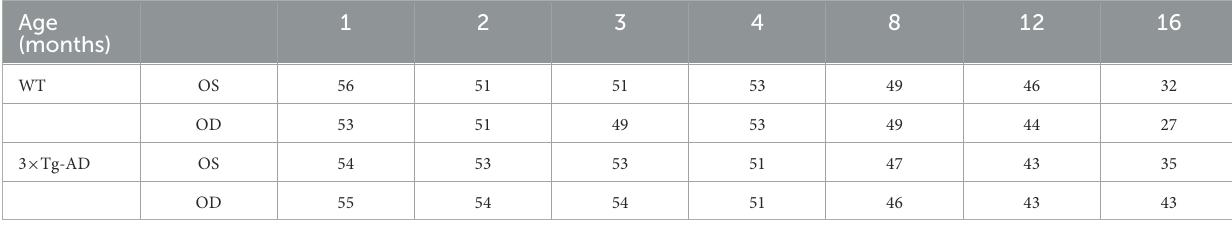
TABLE 1 Total number of OCT data volumes included in this study for wild-type (WT) mice and the triple transgenic Alzheimer’s disease (3 × Tg-AD) mice model, differentiated by age and eye. Age (months)